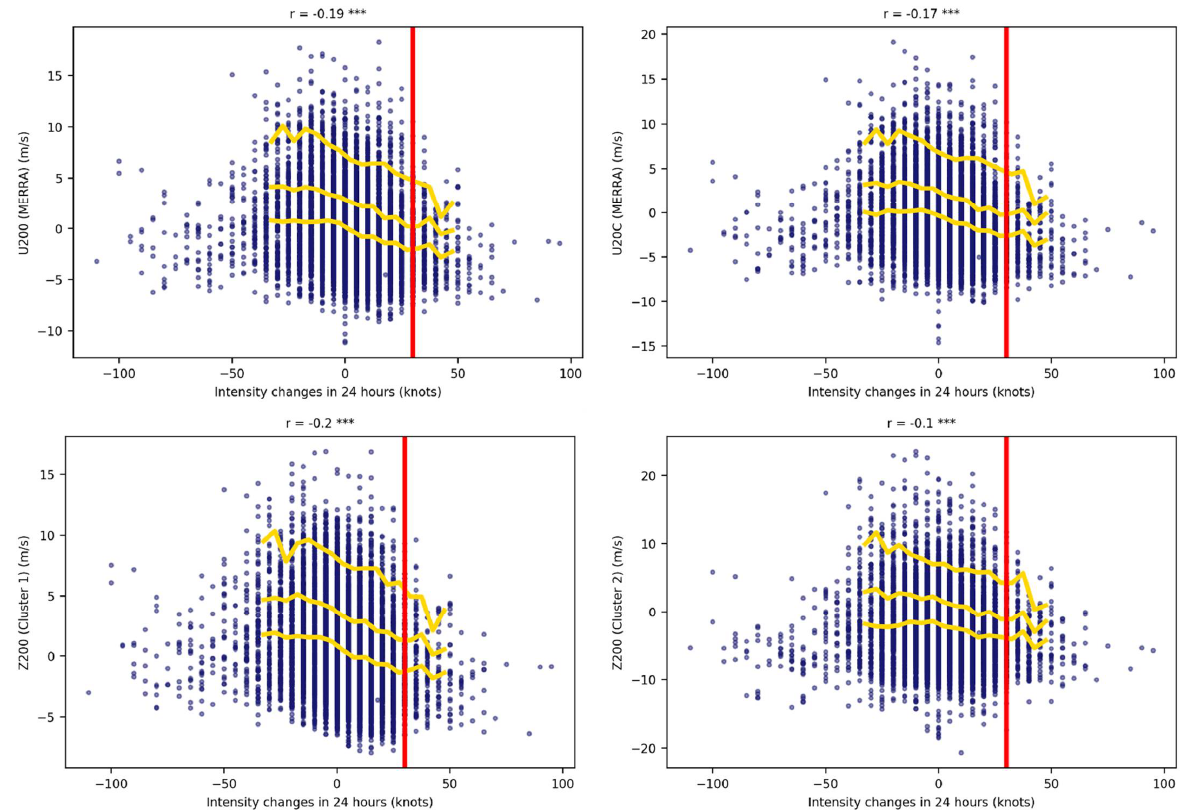
Figure 5. Scatter diagrams of the 24-h TC intensity change versus U200 (MERRA) ( a ), U20C (MERRA) ( b ), Z200 (Cluster 1) ( c ), and Z200 (Cluster 2) ( d ). The red vertical line in each panel shows the boundary of rapid intensification, and the yellow curves show the 95th, 75th, and 50th percentiles in each intensity change bin. Notes: *** p < 0.01;